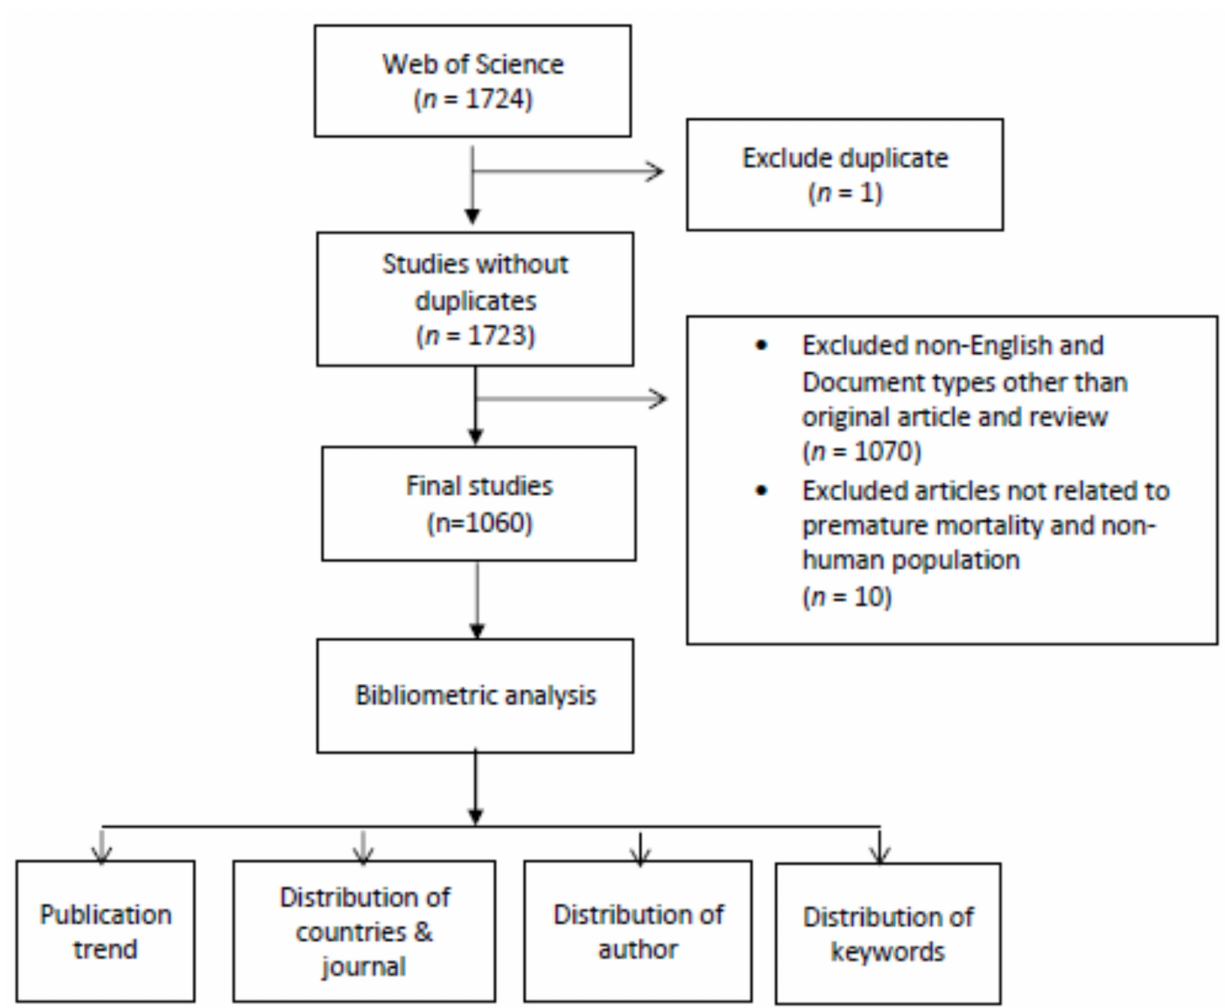
Figure 1. Flow diagram of the study selection